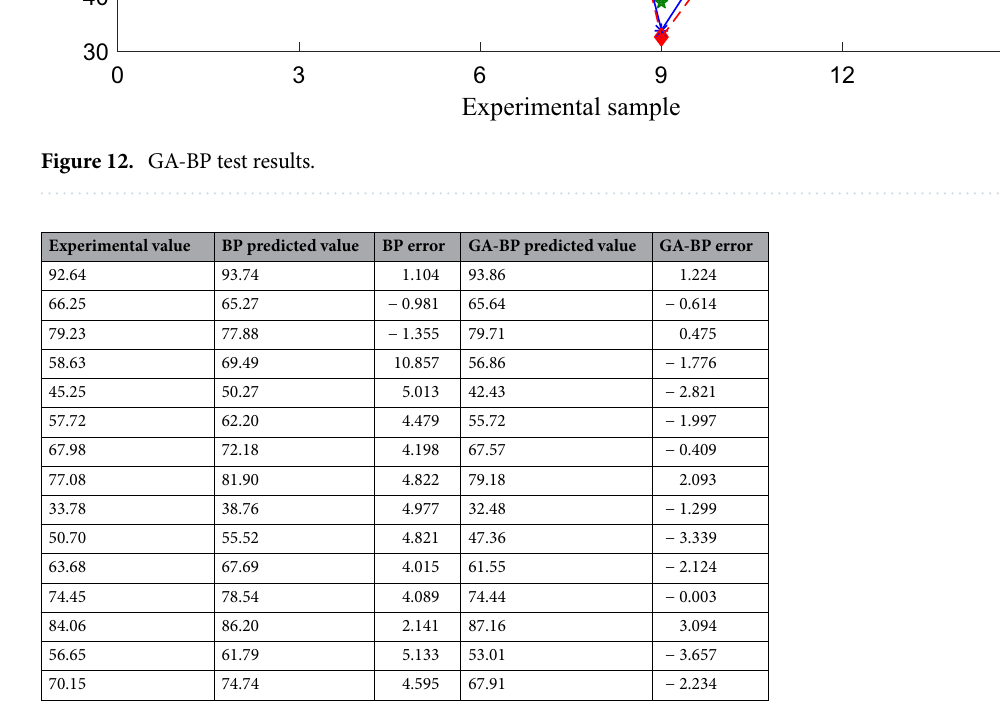
Table 5. GA-BP neural network predicts droplet size SMD results.